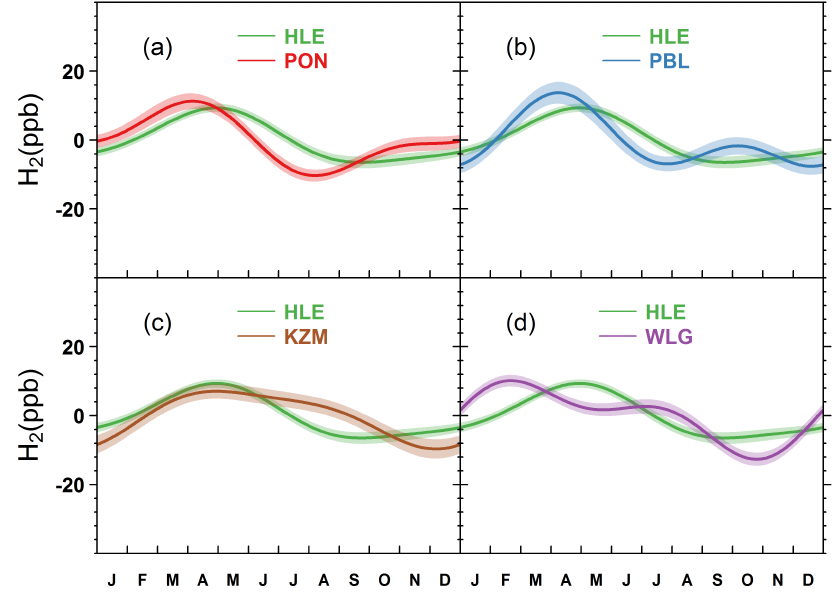
Figure 13. The mean H 2 seasonal cycles observed at (a) HLE and PON, (b) HLE and PBL, (c) HLE and KZM, and (d) HLE and WLG. For each station, the mean seasonal cycle is derived from the harmonics of the smoothed fitting curve in Fig. 12. Shaded area indicates the uncertainty of the mean seasonal cycle calculated from 1 SD of 1000 bootstrap